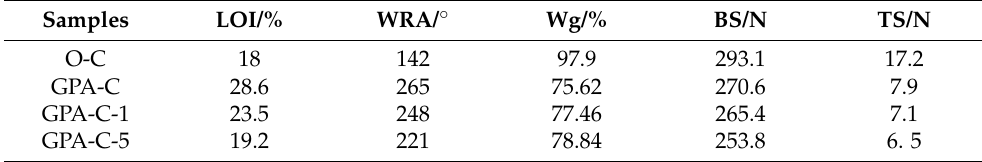
Table 2. Basic properties of fabrics.